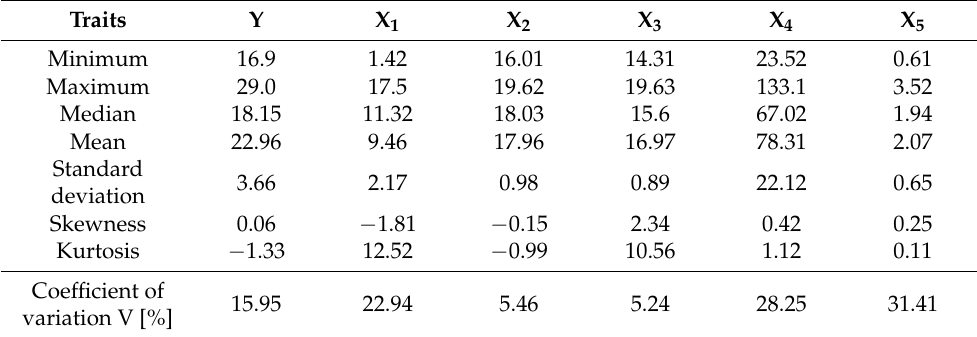
Table 2. Statistical characteristics dependent and independent